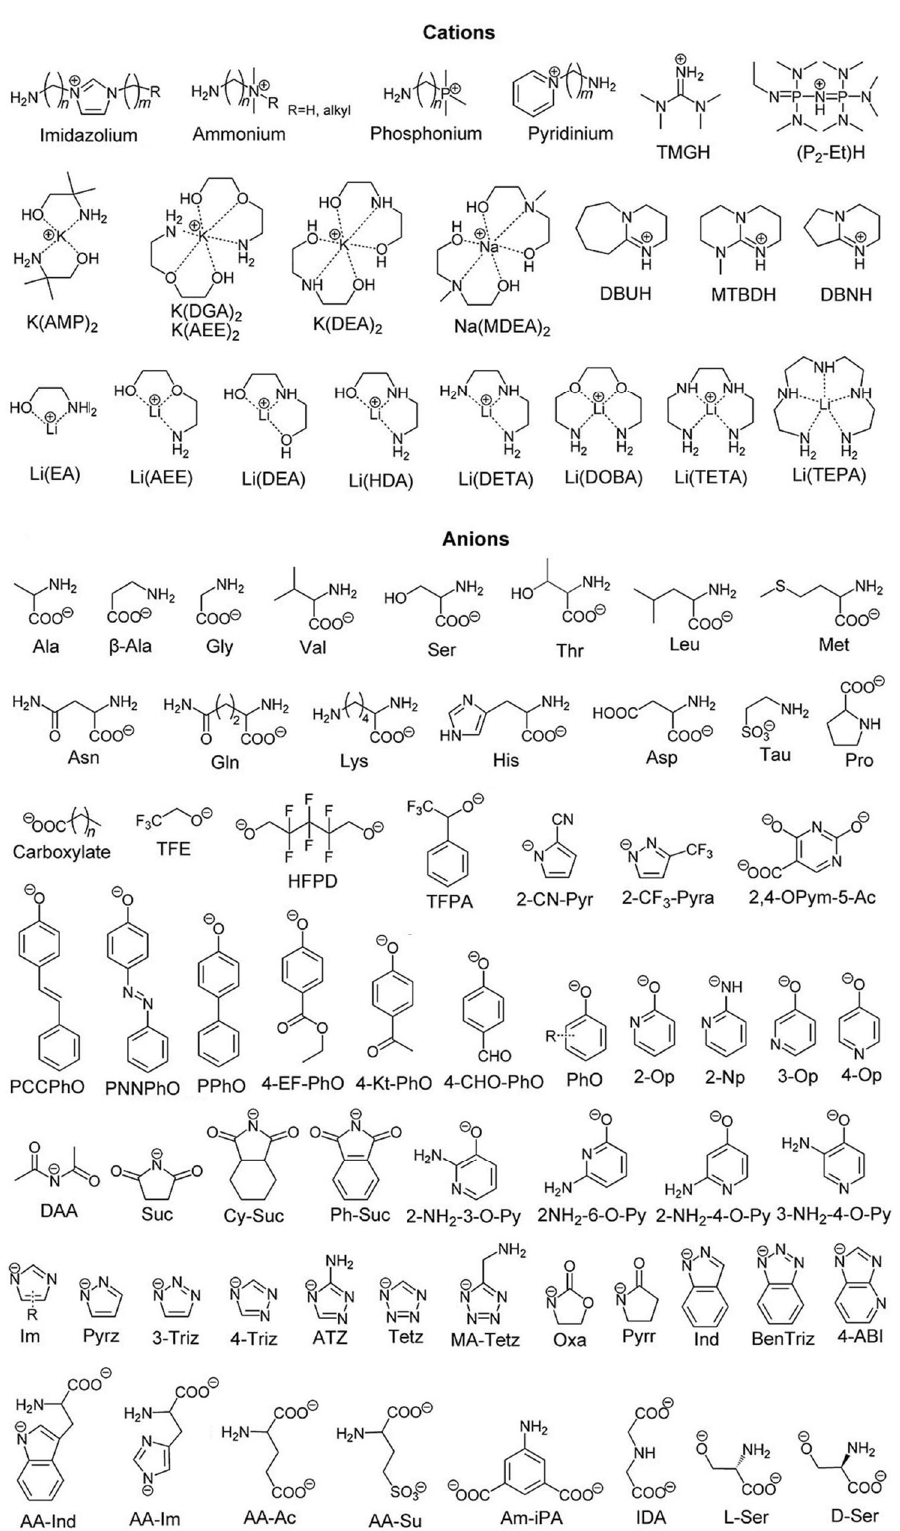
Figure 2. Structures of typical cations and anions used for designing functionalized ILs.